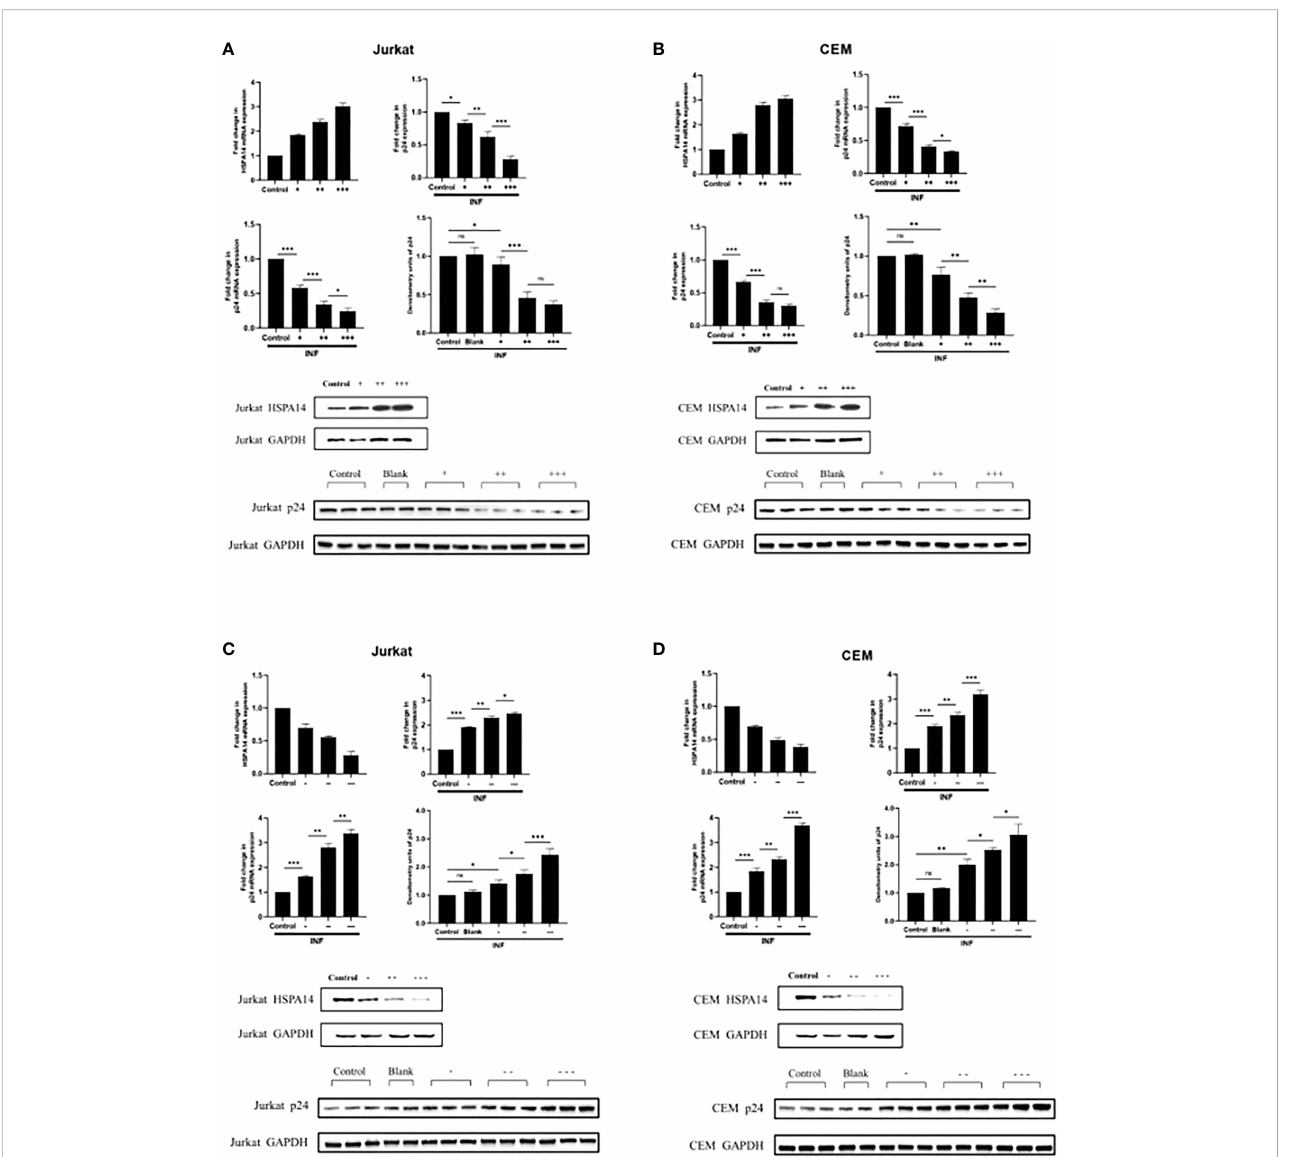
FIGURE 3 HSPA14 can interfere the HIV-1 replication (A) Jurkat cells were transfected with indicated plasmids. 24 hours post-transfection, cells were infected with HIV pseudovirus. 24 hours post-infection, cells were harvested to isolate total RNA and protein, and culture supernatants were collected. Upper left panel: qRT-PCR analysis showing different dose of HSP14 over-expression in Jurkat cells. Upper right panel: Culture supernatants were examined for amount of virus produced using p24 antigen capture ELISA. Middle left panel: qRT-PCR analysis revealing change of p24 mRNA levels. Middle right panel and lower panel: representative western blot and densitometry analysis revealing change of p24 protein levels. (B) CEM cells were transfected with indicated plasmids as Jurkat cells. Upper left panel: qRT-PCR analysis showing different dose of HSP14 over-expression in CEM cells. Upper right panel: Culture supernatants were examined for amount of virus produced using p24 antigen capture ELISA. Middle left panel: qRT-PCR analysis revealing change of p24 mRNA levels. Middle right panel and lower panel: representative western blot and densitometry analysis revealing change of p24 protein levels. (C) Jurkat cells were transfected with indicated RNAi. 24 hours post-transfection, cells were infected with HIV pseudovirus. 24 hours post- infection, cells were harvested to isolate total RNA and protein, and culture supernatants were collected. Upper left panel: qRT-PCR analysis showing different dose of HSP14 knockdown in Jurkat cells. Upper right panel: Culture supernatants were examined for amount of virus produced using p24 antigen capture ELISA. Middle left panel: qRT-PCR analysis revealing change of p24 mRNA levels. Middle right panel and lower panel: representative western blot and densitometry analysis revealing change of p24 protein levels. (D) CEM cells were transfected with indicated RNAi as Jurkat cells. Upper left panel: qRT-PCR analysis showing different dose of HSP14 knockdown in CEM cells. Upper right panel: Culture supernatants were examined for amount of virus produced using p24 antigen capture ELISA. Middle left panel: qRT-PCR analysis revealing change of p24 mRNA levels. Middle right panel and lower panel: representative western blot and densitometry analysis revealing change of p24 protein levels. Control: cell lines were transfected with vector plasmids as control. Blank: cell lines were not transfected with any plasmids as blank control. +: 500ng/ m l of HSPA14 overexpression plasmid, ++: 1 m g/ m l of HSPA14 overexpression plasmid, +++: 2 m g/ m l of HSPA14 overexpression plasmid. -: 50nM of HSPA14 shRNA plasmi, – : 100nM of HSPA14 shRNA plasmid, — : 200nM of HSPA14 shRNA plasmid.The error bars are presented as the mean ± SD values and signi fi cance is de fi ned as *P ≤ 0.05, **P ≤ 0.01 and ***P ≤